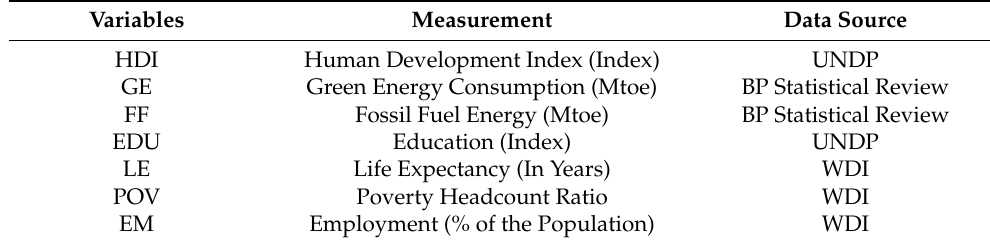
Table 3. Data and variables